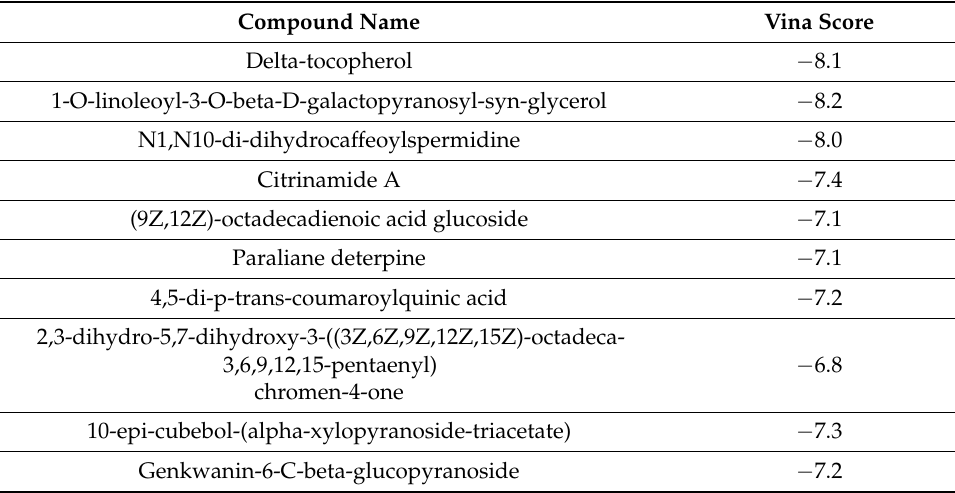
Table 1. Docking of the top ten compounds using AutoDock